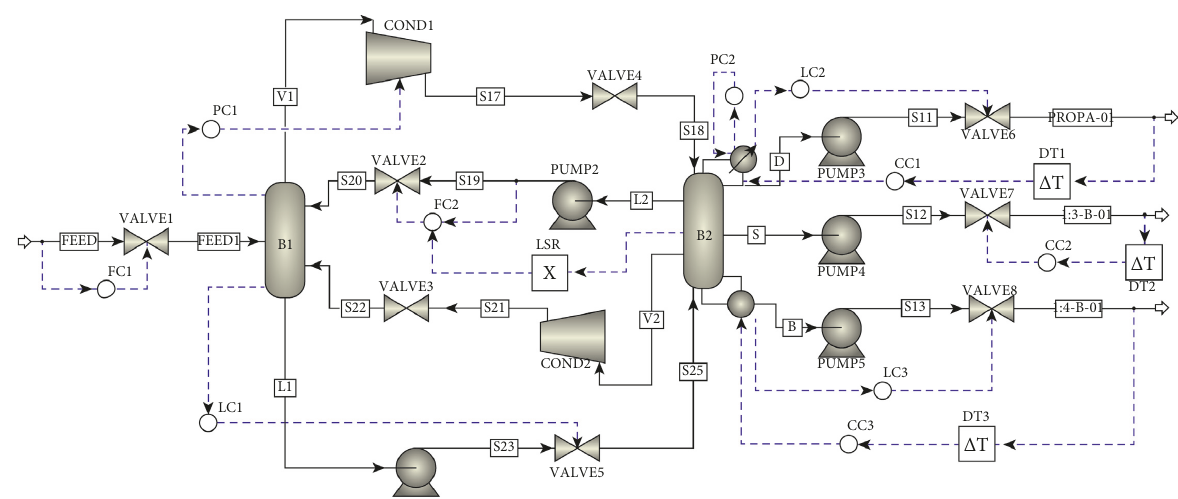
Figure 5: Composition control structure CS2 of